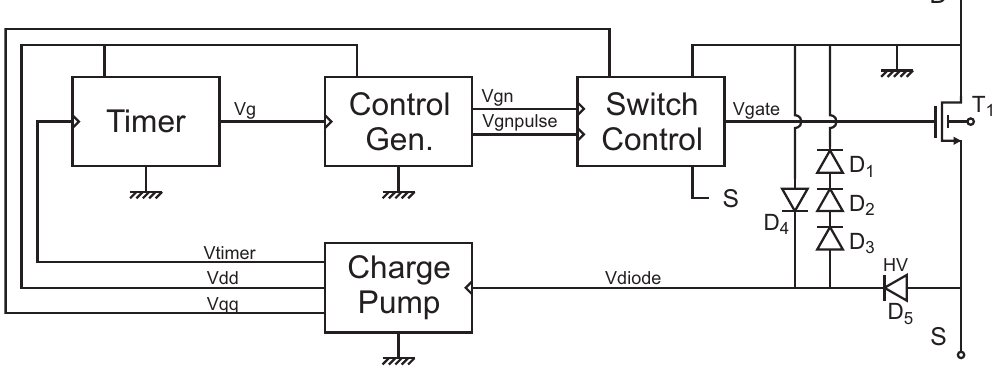
Figure 2. The block diagram of the NMOS-based Integrated Modular Bypass for Use in Solar systems (NIMBUS)